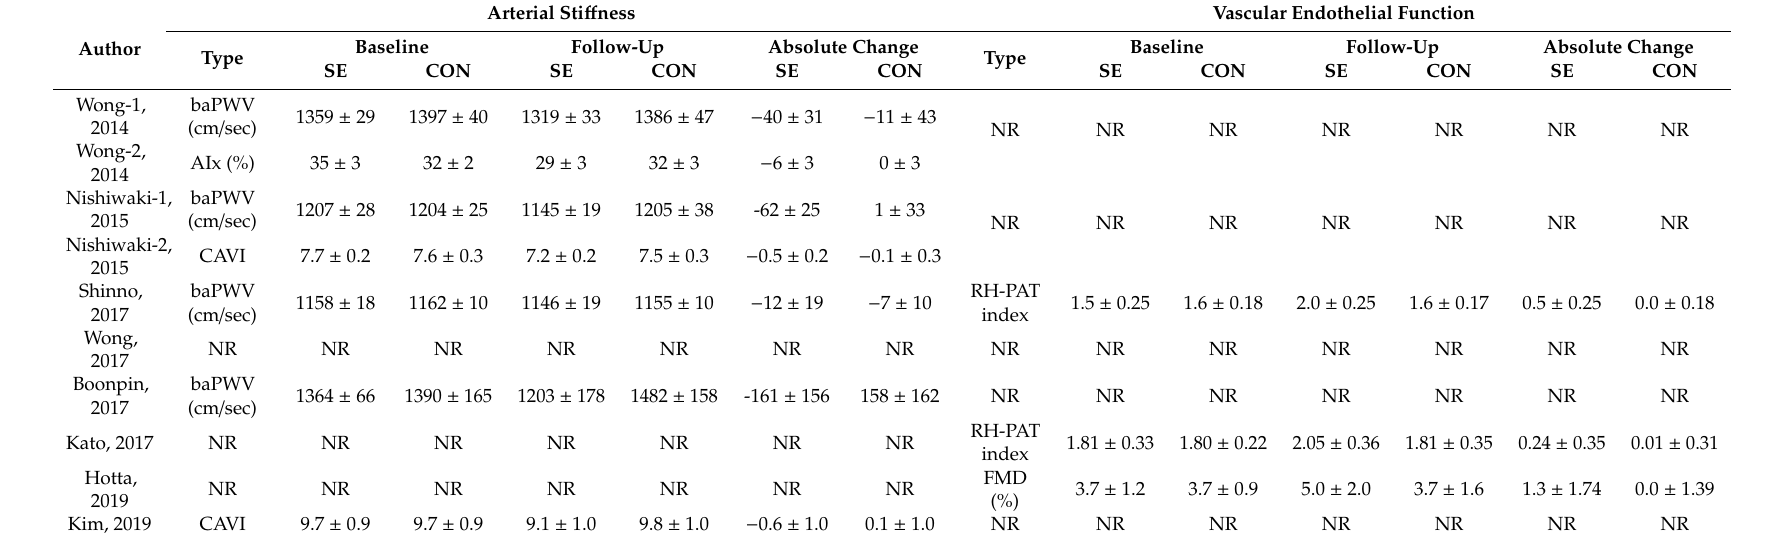
Table 3. Changes in parameters of arterial sti ff ness and vascular endothelial